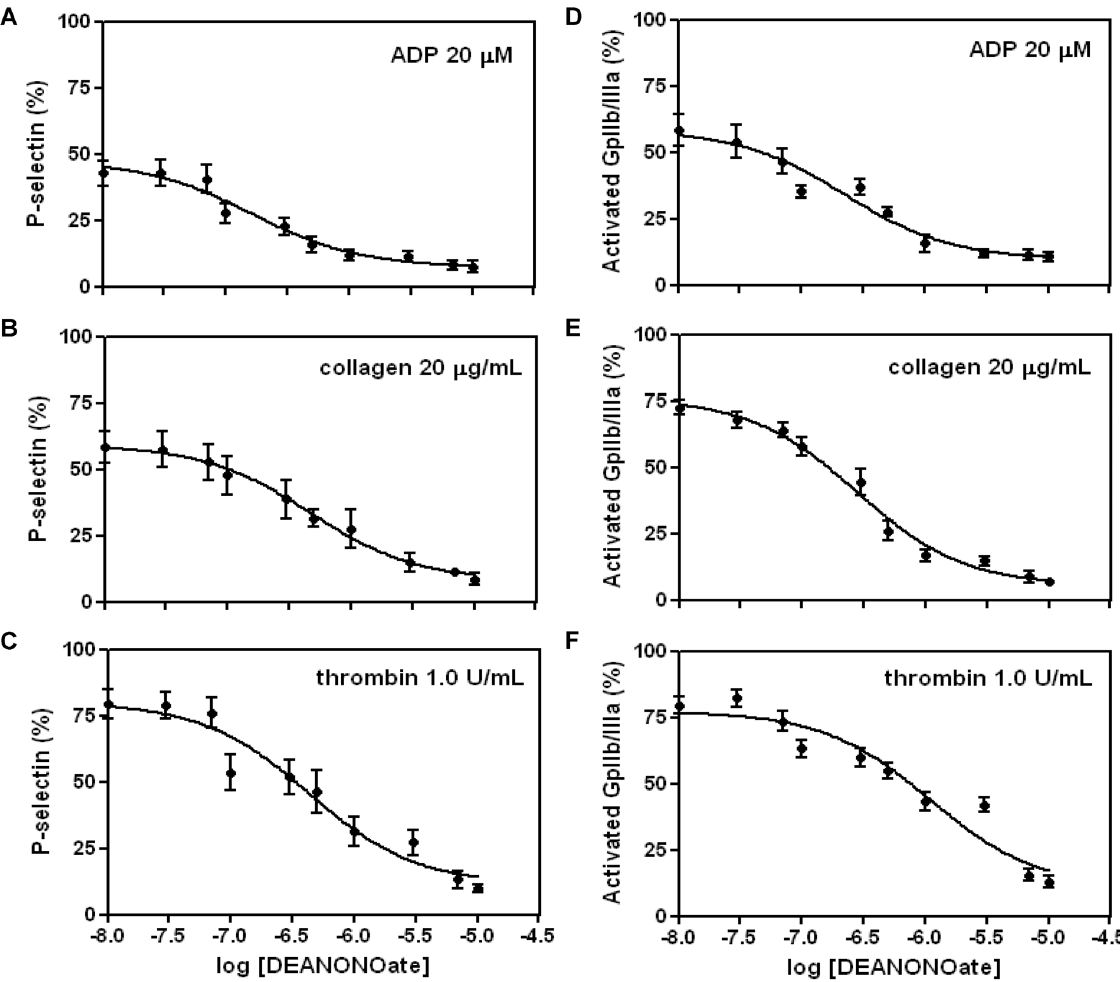
Figure 1. Effect of DEANONOate on platelet activation in platelet-rich plasma + erythrocytes. Platelet activation was induced by ADP (A, D, 20 m M), collagen (B, E, 20 m g/mL) and thrombin (C, F, 1 U/mL) in platelet-rich plasma + erythrocytes preincubated with DEANONOate at 37 u C for 2 minutes. Platelet activation was analyzed by measuring the percentage of cells expressing P-selectin (A, B, C) and activated gpIIb/IIIa (D, E, F) on the membrane using specific antibodies (CD62P and PAC-1, respectively, mean Hct 40%, mean pO 2 49 mmHg, n=6).